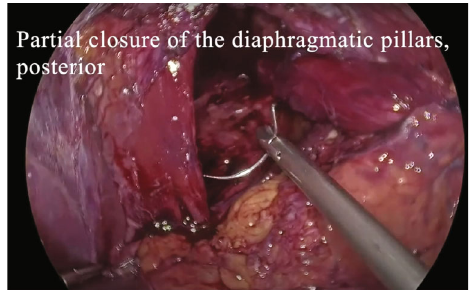
Figure 4: Video screenshot: closure of